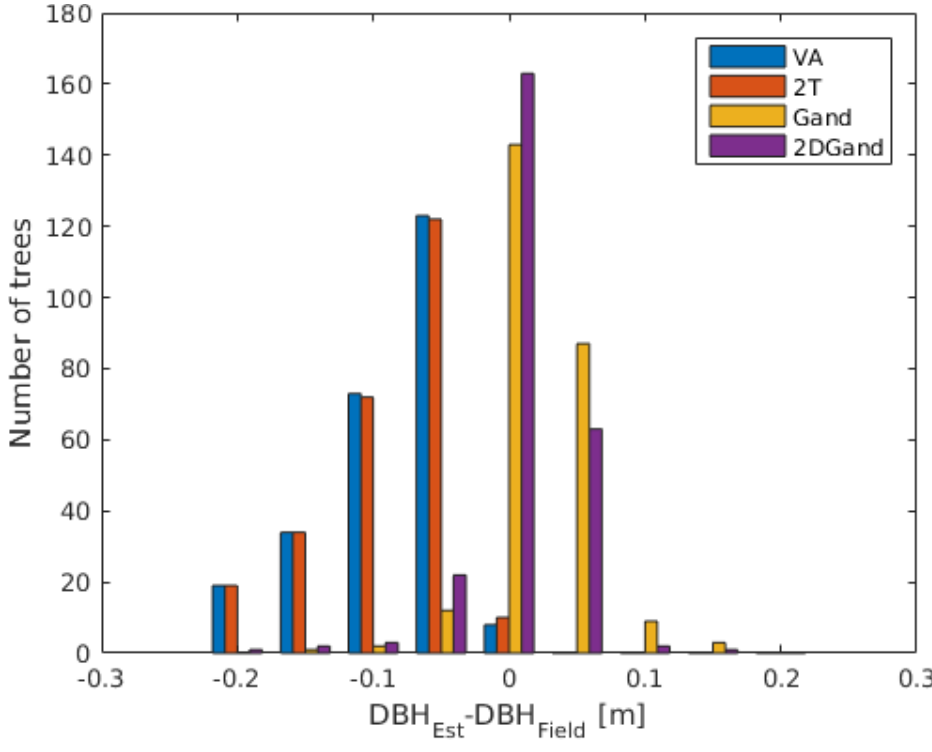
Figure 12. Histogram over DBH Est - DBH Field for all matched trees. Ganders’ direct method on 2D projected points (2DGand) has the smallest bias. The trigonometric methods VA (viewing angle) and 2T (two triangle) underestimate